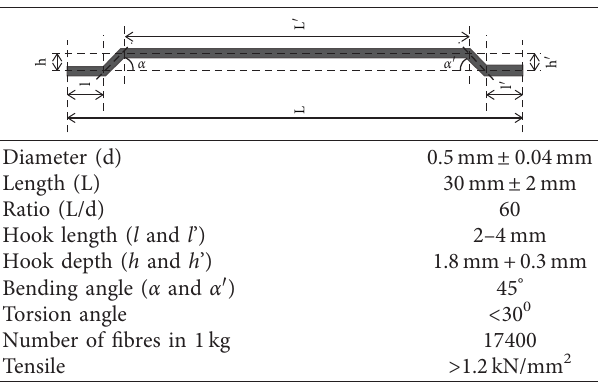
Table 2: Parameters of Dramix steel fibres in